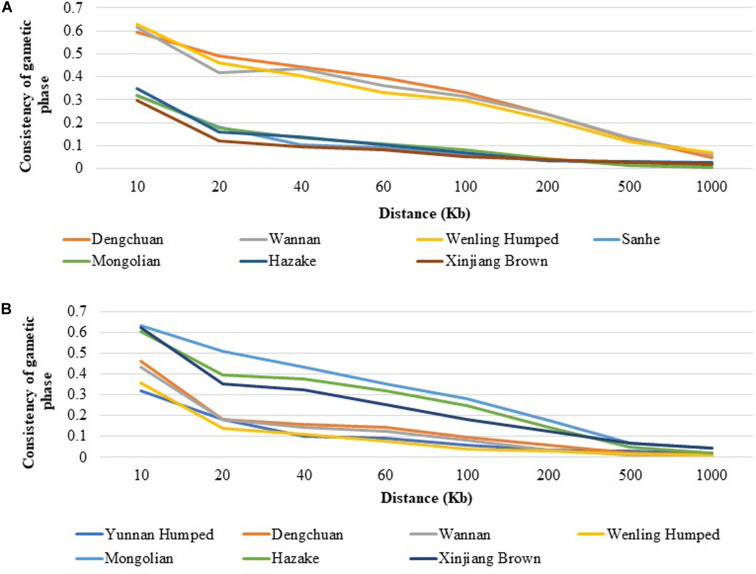
Consistency of gametic phase at given distances between (A) Yunnan Humped and seven Chinese cattle breeds, and (B) Sanhe and seven Chinese cattle breeds.